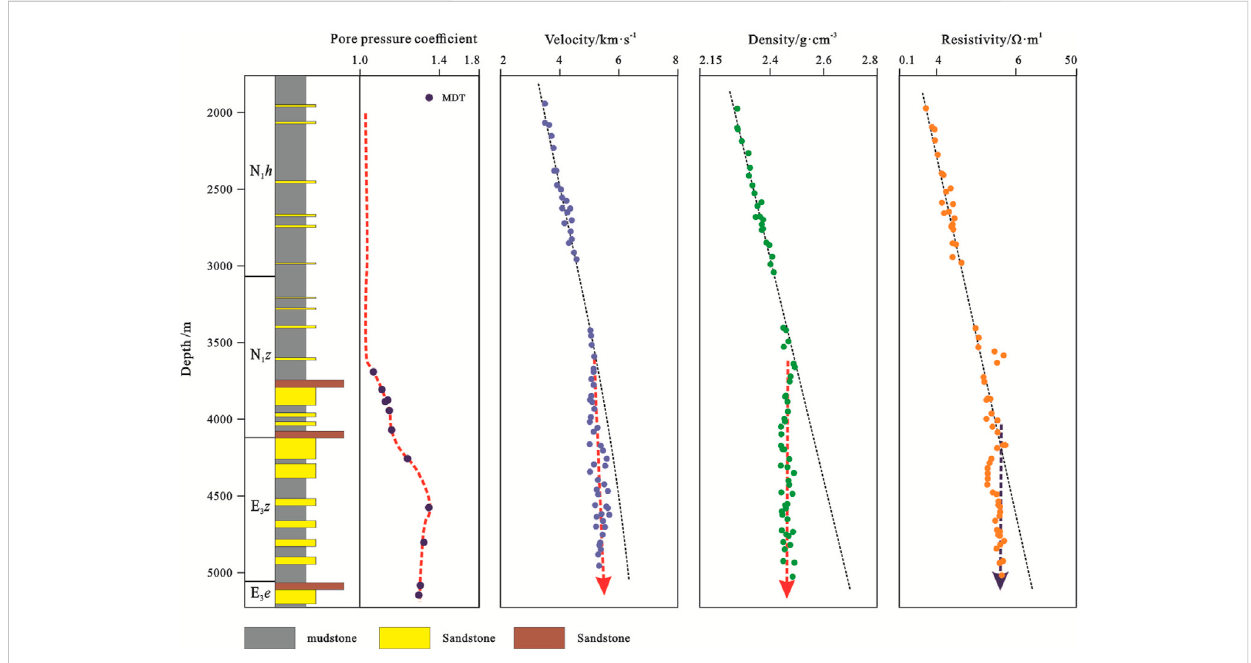
FIGURE 4 Calculation results of pore formation pressure and depth pro fi les of well-logging parameters, including velocity, density, resistivity and MDT data from Well BY01.